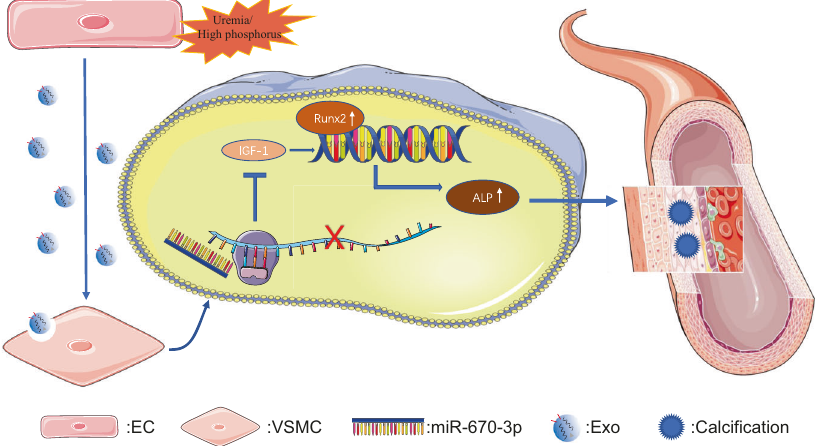
Fig. 8 The mechanism diagram about arterial calci fi cation mediated by crosstalk between ECs and VSMCs. Under uremia/high phosphorous conditions, ECs released exosomal miR-670-3p, promoting the expression of Runx2 and subsequently ALP to accelerate VSMC calci fi cation, which was further accomplished by downregulating IGF-1. Finally, the accumulation of VSMCs calci fi cation resulted in calci fi ed